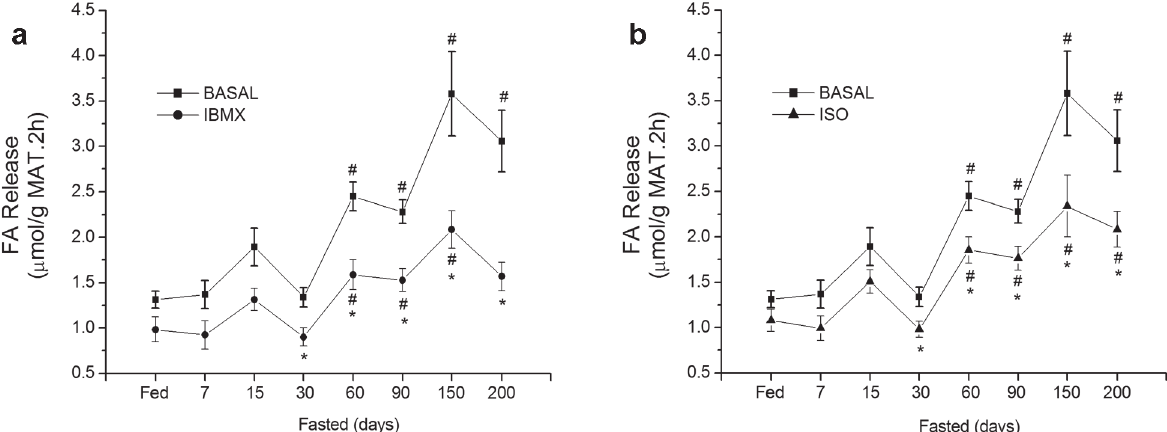
figure 2 - Fatty acids (FA) mobilization (mmol.g -1 MAT.2h) from mesenteric adipose tissue (MAT) of fed and fasted red tilapia ( Oreochromis sp) in basal condition (■) or in presence of 10 -3 M IBMX (●) (a) or 10 -5 M ISO (▲) (b) . * (P<0.05) vs basal; # (P<0.05) vs fed. Values are mean ± SEM (n=10 fish for fed and for each fasting period). IBMX: 3-isobutyl-1-methylxanthine; ISO: